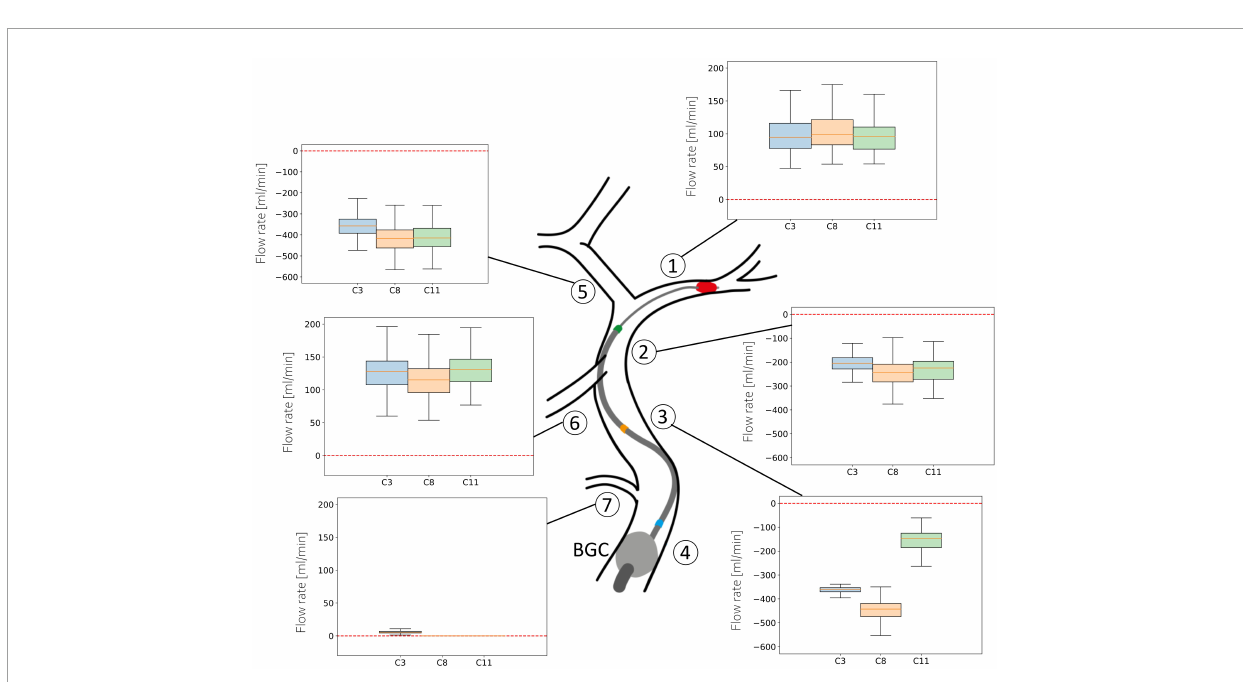
FIGURE7 Haemodynamic conditions in the vessels neighboring the retrieval path. Results are shown for the 211 subjects in the 65 year old population with 5 ml/s aspiration rate in configurations C3, C8, and C11. Details of the configurations are given in Table 3